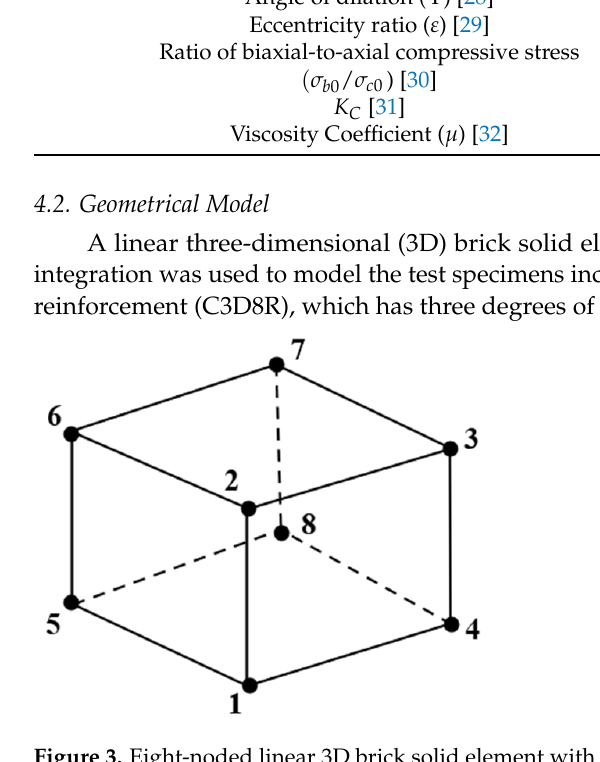
Table 3. Details of plasticity parameters.